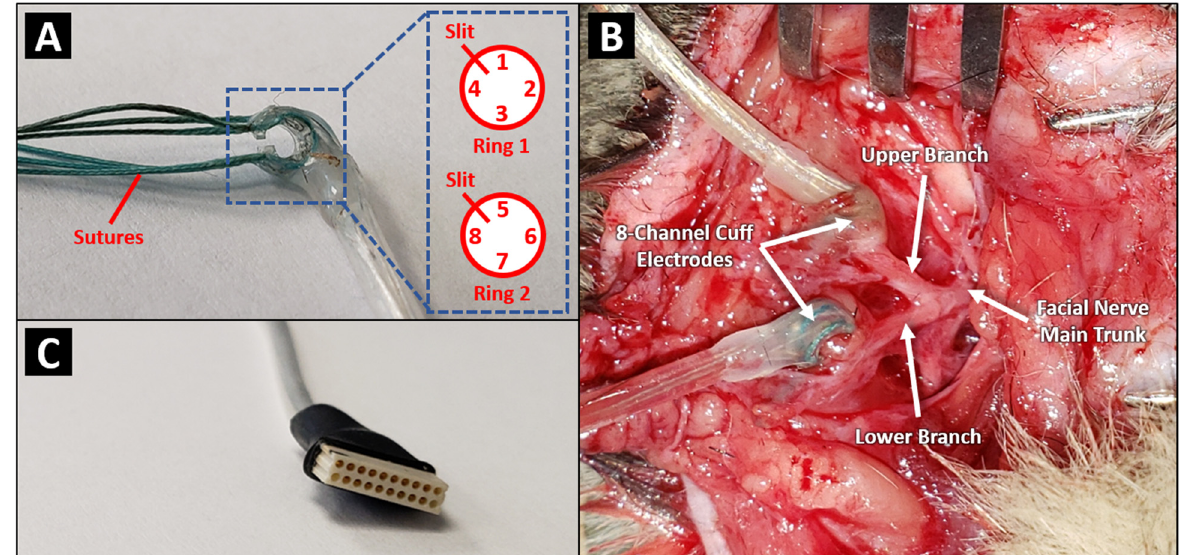
Figure 1. (A) 8 ‐ channel MCE consisting of 2 parallel electrode rings, in each of which 4 rectangular platinum electrodes were arranged 90 degrees apart within a silicon enclosure. (B) Intra ‐ operative image of the two MCEs implanted at the upper and lower FN branches of Cat A. (C) Photograph of the male Omnetics connector originating from the MCE in (A).